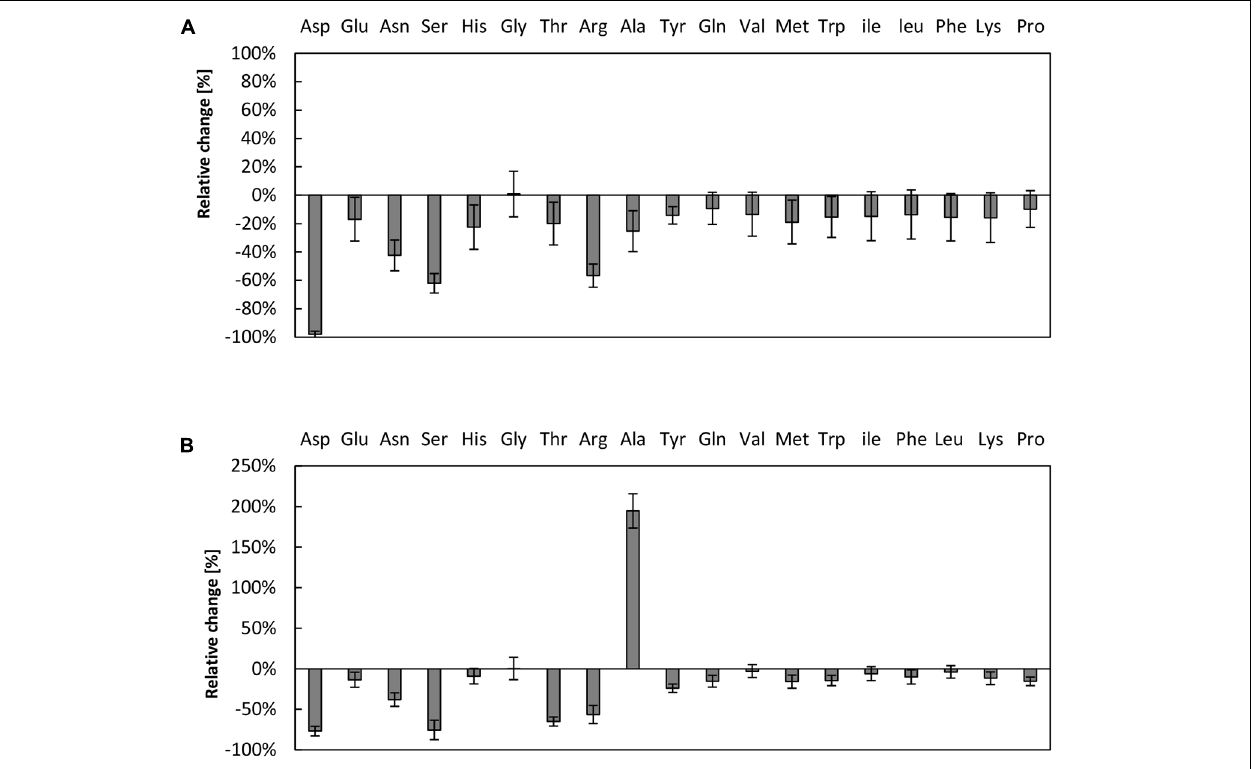
FIGURE 3 | Amino acid degradation in the V. natriegens CFPS system. Relative concentrations of amino acids after 3 h of CFPS fueled by (A) creatine phosphate or (B) PEP. Initial concentrations were set to 1 mM of each amino acid. Note that cysteine could not be reliably measured using our analysis method. Error bars represent standard deviations of triplicate